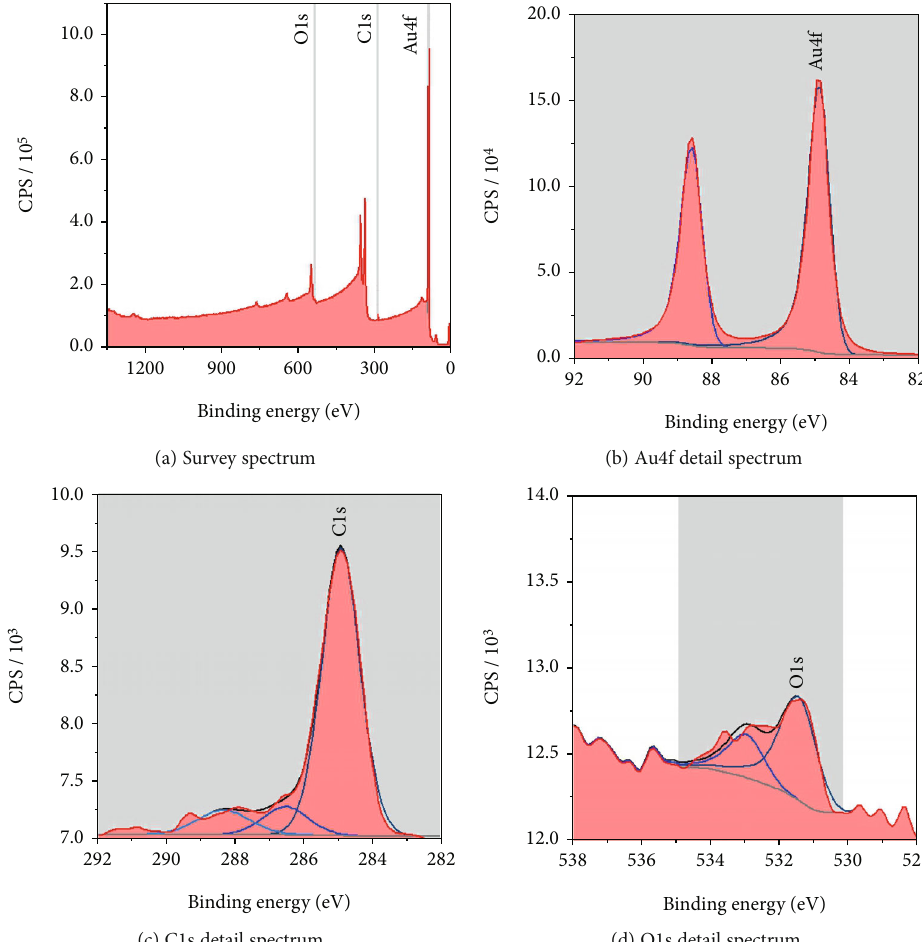
Figure 2: XPS survey and detail spectra of a gold-sputtered silicon wafer measured at a detector angle of 90 ° to the surface, after cleaning three times in a supersonic bath with cyclohexane (CCC sample). Counts per second (CPS) are plotted as function of electron binding